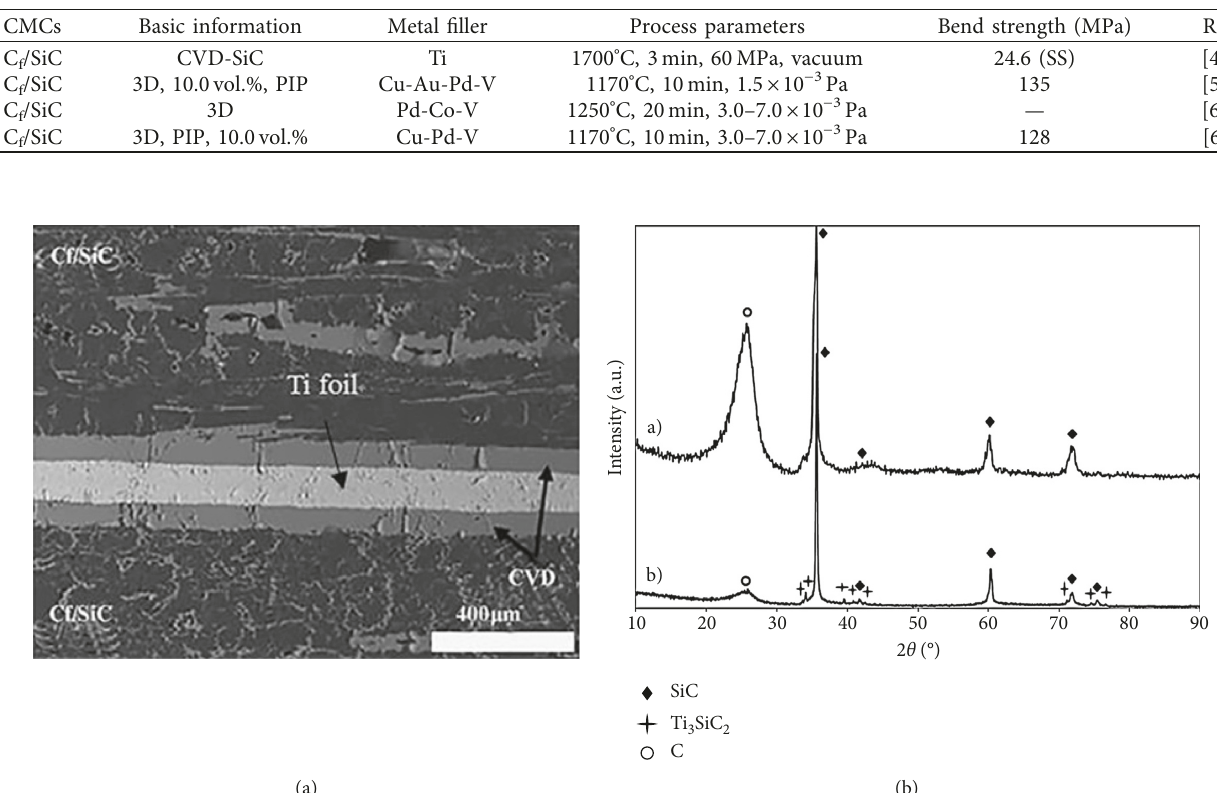
Figure 4: (a) Backscattered electron images of polished cross sections and (b) micro-XRD on the fracture surfaces of C with Ti foil [48].